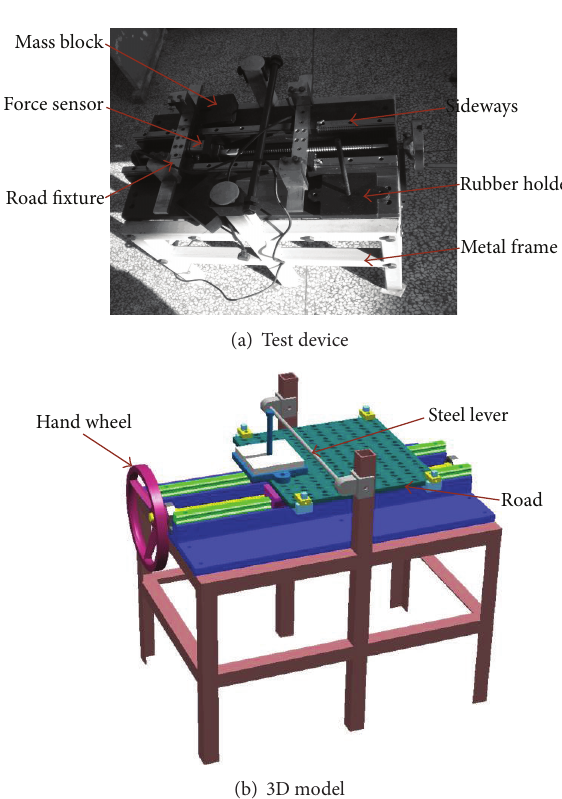
Figure 2: Road samples.